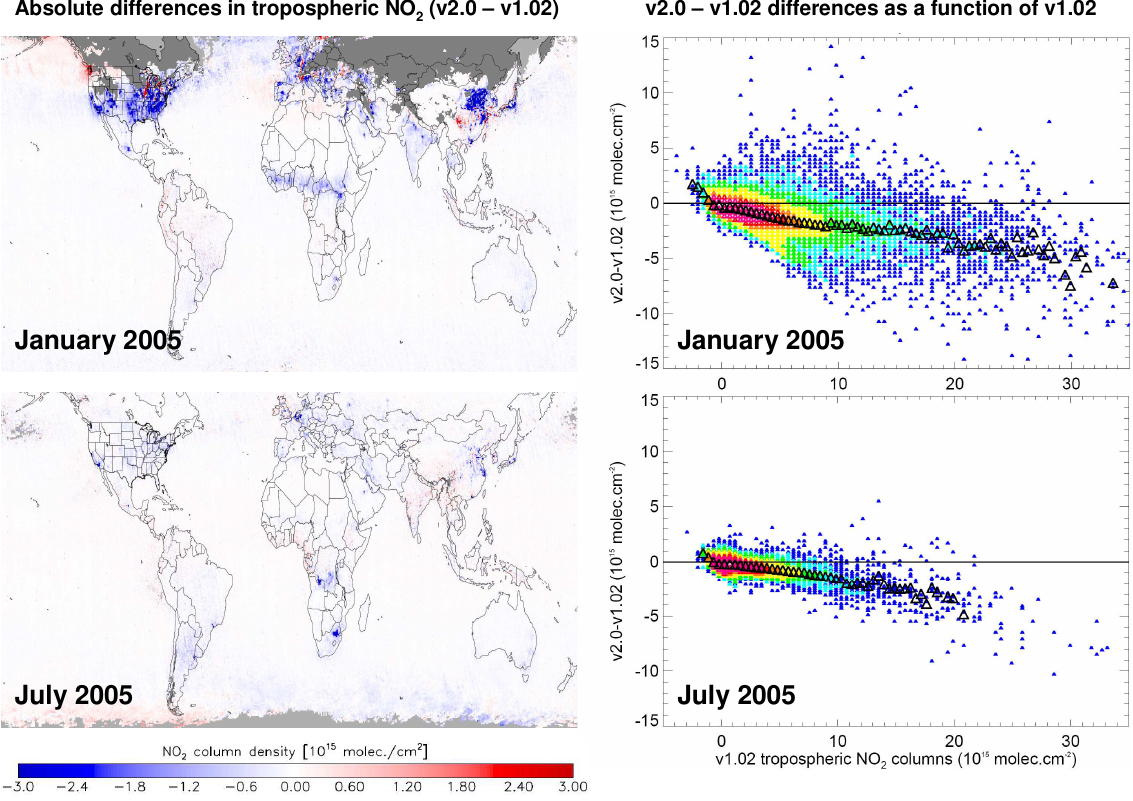
Fig. 10. Monthly average difference between v2.0 and v1.02 DOMINO tropospheric NO 2 column retrievals for January 2005 and July 2005 (left panels). Cloudy scenes (cloud radiance fractions > 0.5) have been omitted in calculating the monthly mean. The right panels show the difference between v2.0 and v1.02 as a function of the original (binned) monthly mean v1.02 values. Blue symbols indicate bins filled with 1–3 values, light blue 4–9, green 10–29, yellow 30–99, orange 100–199, red 200–399, and purple more than 400 values. The black triangles indicate the mean difference for a particular bin.